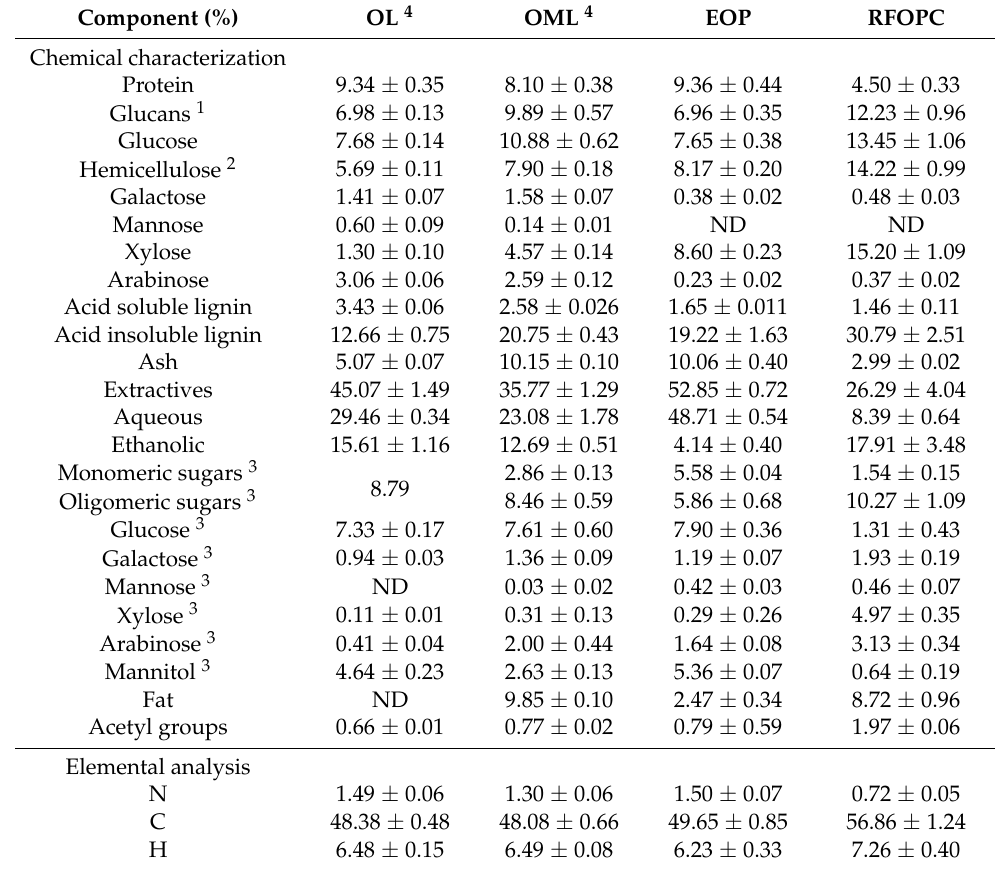
Table 1. Chemical composition of olive leafy and pomace-derived